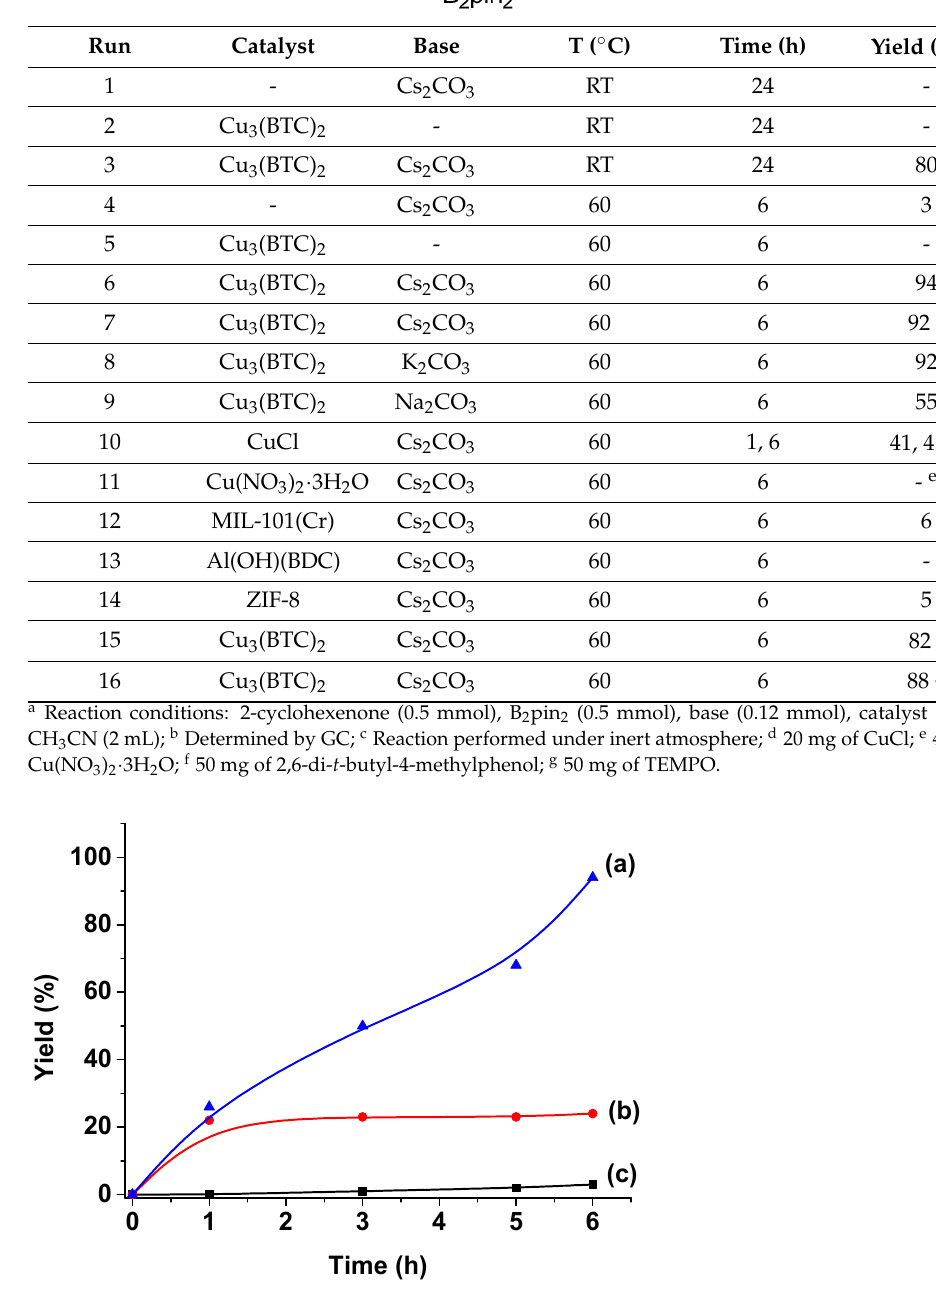
Table 1. Borylation of 2-cyclohexenone using B 2 pin 2 under various reaction conditions a .